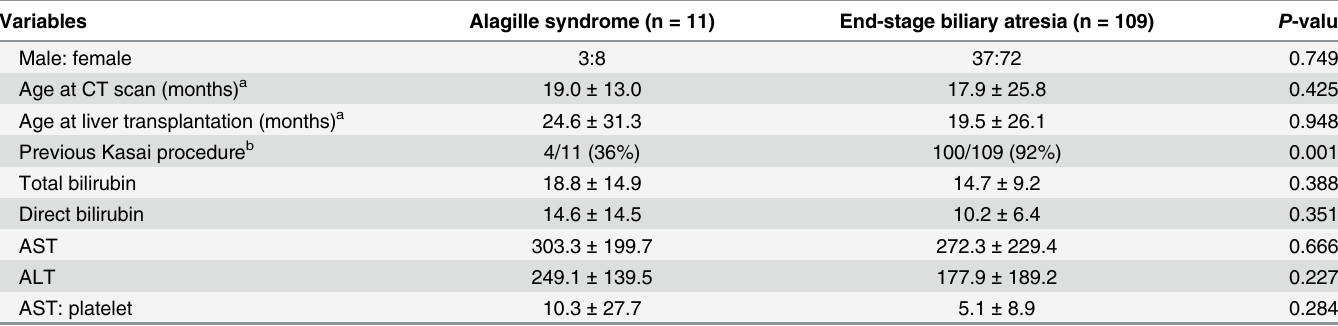
Table 1. Clinical profile and laboratory data.